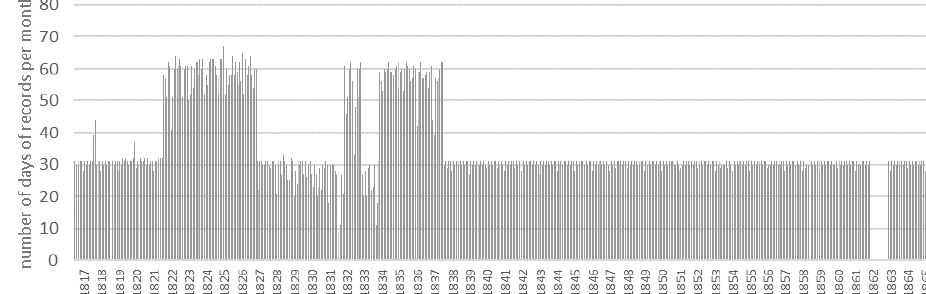
Figure 4. Number of records of daily weather per month at Trentham (August 1816–1865).